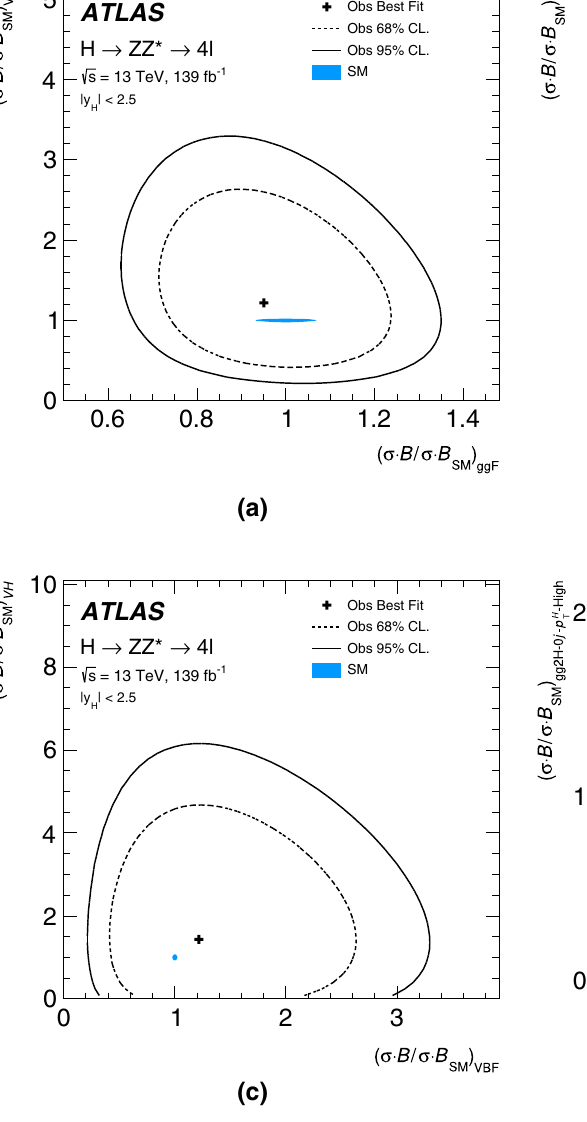
is shown together with its theory uncertainty (filled ellipse). The VH parameter of interest is constrained to positive